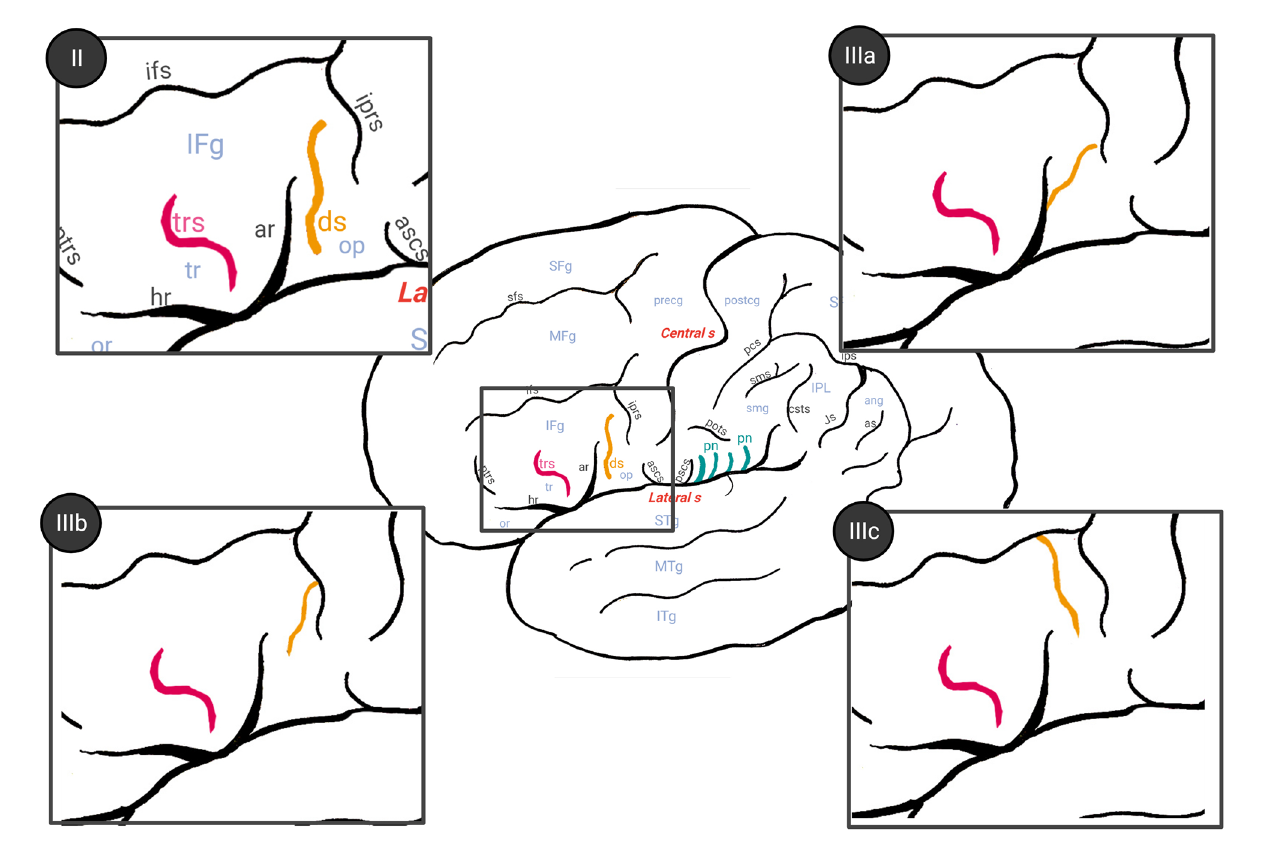
FIGURE2 DifferentpatternsofdiagonalsulcuspreviouslydescribedbySprung-MuchandPetrides(2018)(drawingbasedonthatarticle).Colorlegend:ds(inorange), diagonal sulcus; trs (in pink), triangular sulcus. Type II: diagonal sulcus is separated with respect to other neighboring sulci. Type IIIa: diagonal sulcus joins superficially with the anterior ascendent ramus of the lateral sulcus. Type IIIb: idem but with the inferior precentral sulcus. Type IIIc: diagonal sulcus links superficially with the inferior frontal sulcus. In the present study, we considered Type I as 0 (absent diagonal sulcus), while type II and III a, b and c were considered as 1 (present).